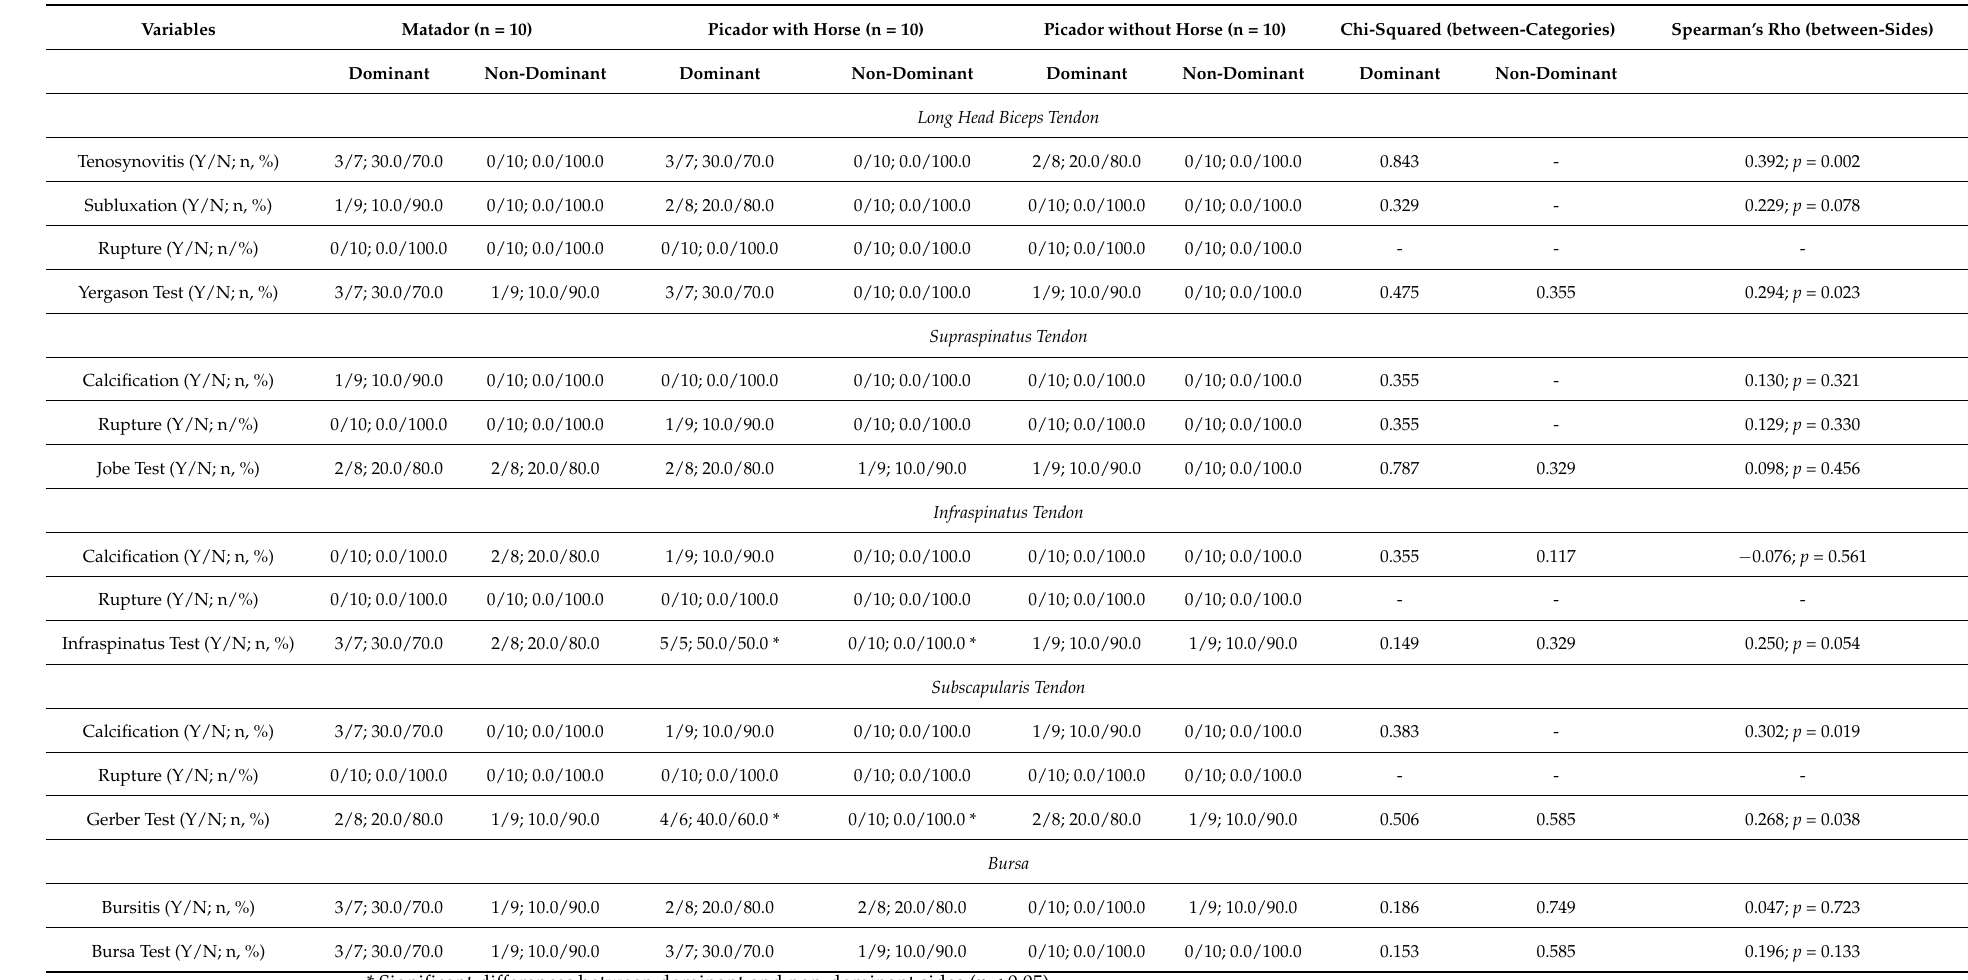
Table 2. Clinical and Ultrasonographic